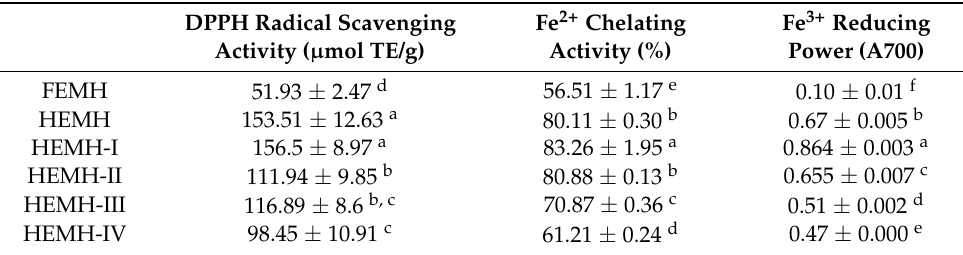
Table 3. The antioxidant activities of fresh ESM hydrolysates (FEMH), hatched ESM hydrolysates (HEMH), and the ultrafiltration fractions of